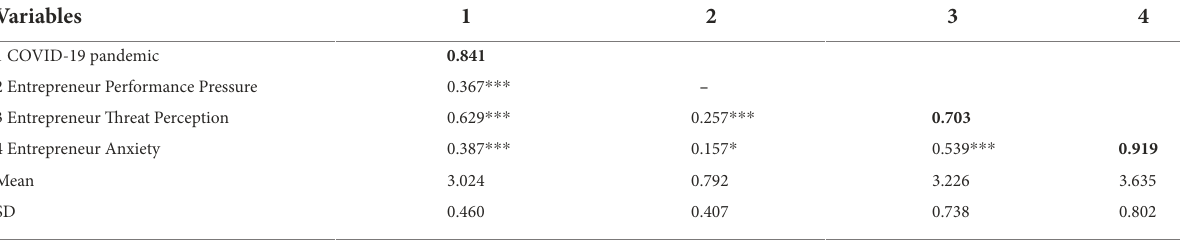
TABLE 4 Means, standard deviations and correlations coefficients.